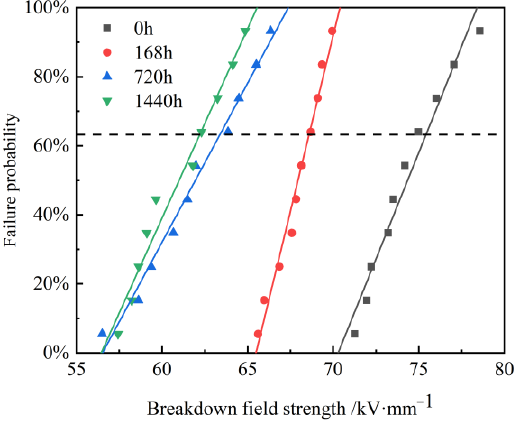
Figure 4. Variation law of breakdown field strength of insulation layer under different aging time. Table 1. Weibull distribution parameters for XLPE breakdown strength at different thermal aging time.